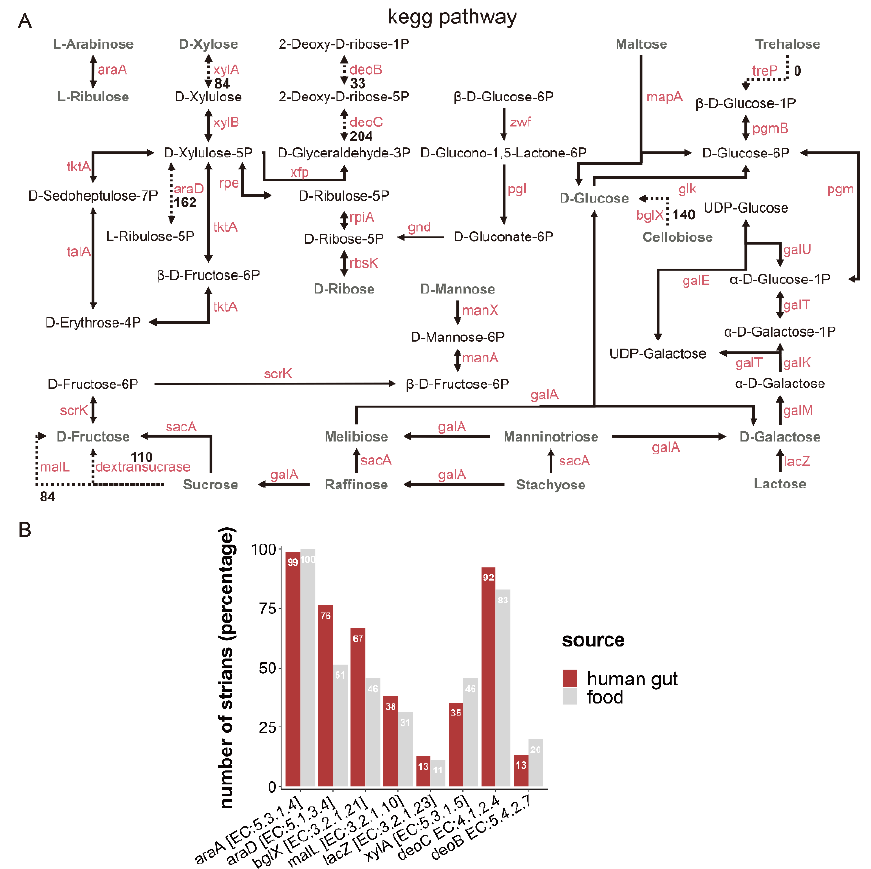
Figure 5. Metabolism of carbohydrates and related metabolic pathways of L. fermentum . ( A ) Schematic representation of CAZy in the metabolic pathway of the 224 L. fermentum strains. The solid lines indicate that more than 220 L. fermentum strains contained the enzyme. The dotted lines meant that the enzyme was present in fewer than 220 L. fermentum strains and the number of strains containing the enzyme is denoted by the dotted line; ( B ) number of genes encoding the enzymes (L-arabinose isomerase [EC: 5.3.1.4], araA; L-ribulose-5-phosphate 4-epimerase [EC: 5.1.3.4], araD; beta-glucosidase [EC: 3.2.1.21], bglX; oligo-1,6-glucosidase [EC: 3.2.1.10], malL; beta-galactosidase [EC: 3.2.1.23], lacZ; xylose isomerase [EC: 5.3.1.5], XylA; deoxyribose-phosphate aldolasebeta-glucosidase [EC: 4.1.2.4], deoC; phosphopentomutase [EC: 5.4.2.7], deoB) in the genome of L. fermentum strains from different sources.